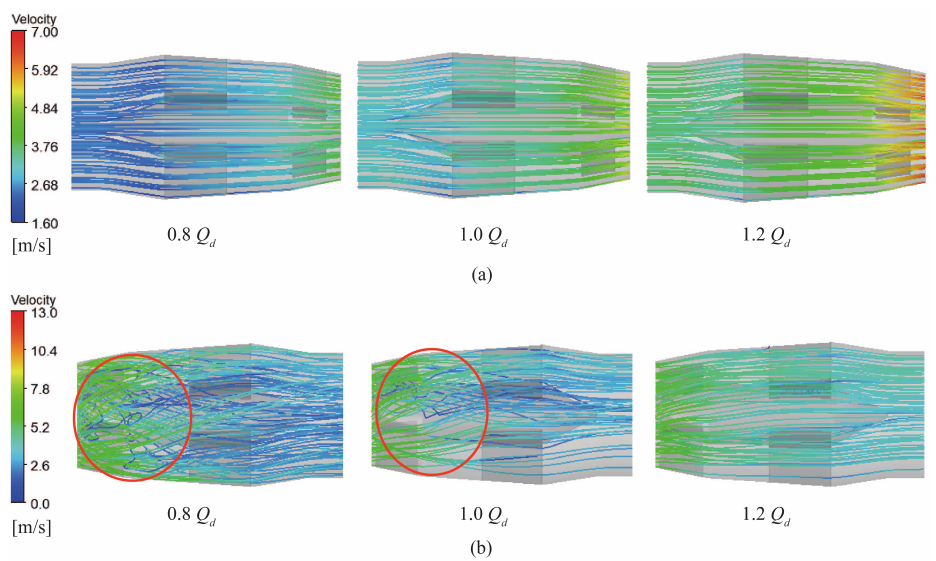
Figure 8. Three-dimensional flow lines in the bulb: ( a ) front-mounted scheme; ( b ) rear-mounted scheme.